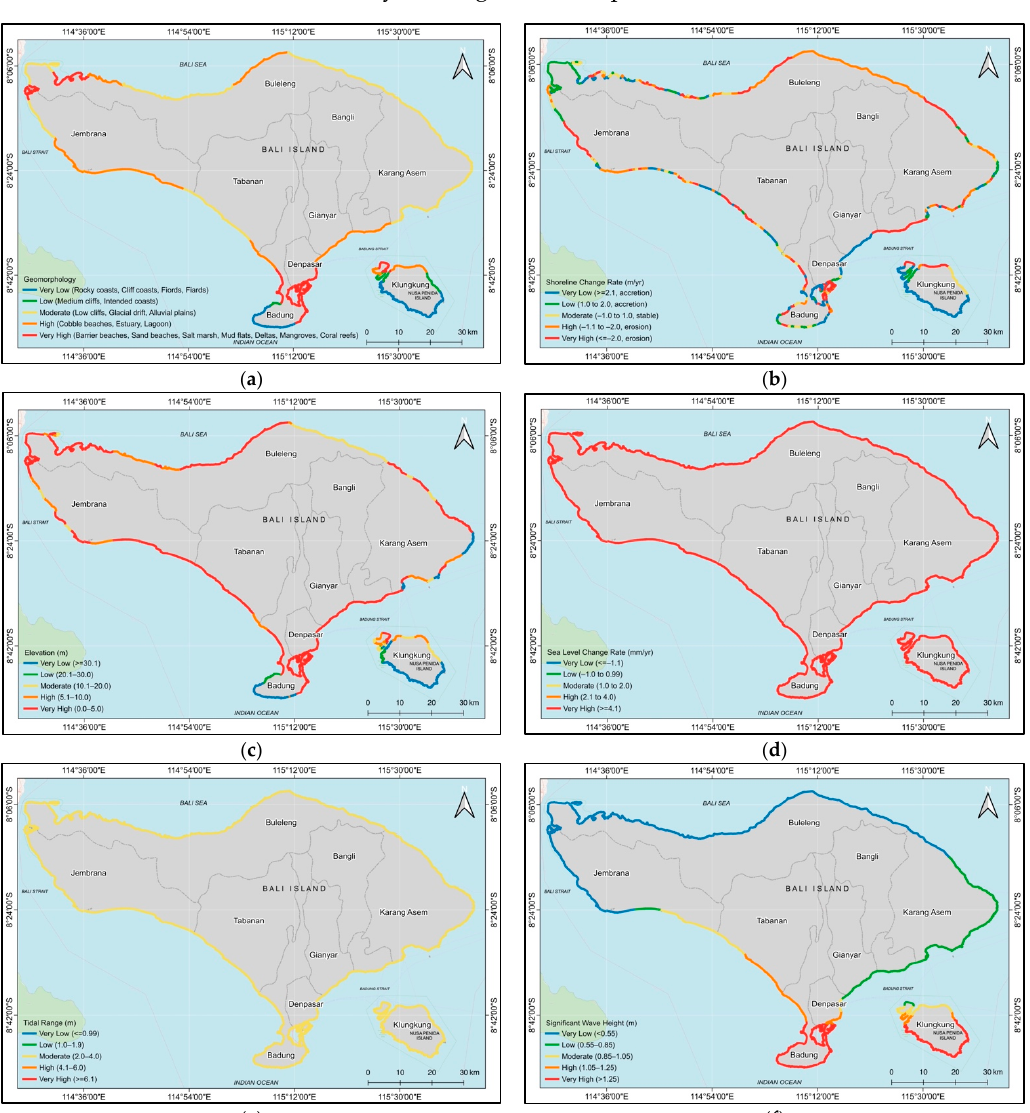
Figure 5. Vulnerability rank of ( a ) geomorphology; ( b ) shoreline change; ( c ) elevation; ( d ) sea level; ( e ) tidal range; and ( f ) significant wave height.